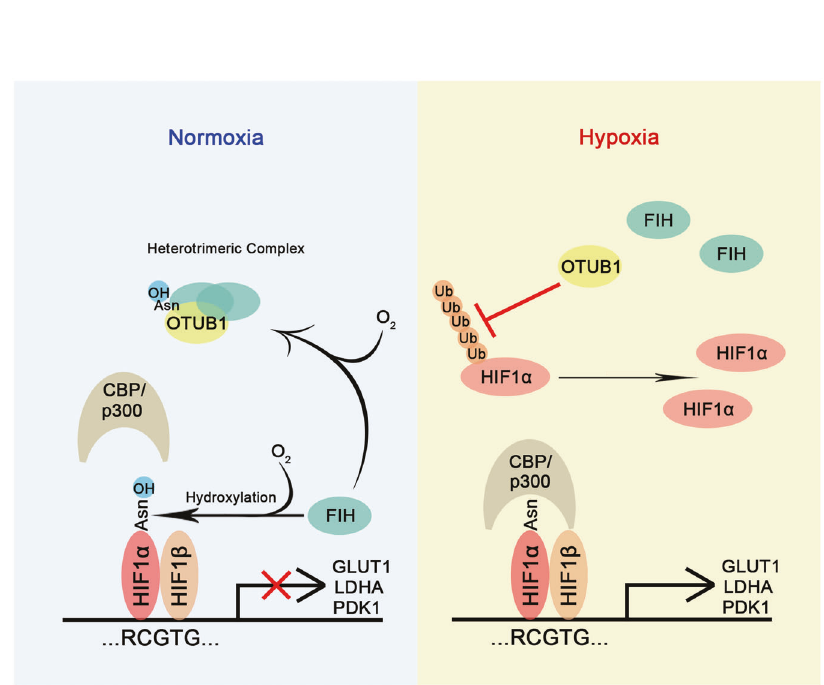
Fig. 7 OTUB1 facilitates hypoxia adaptation. A – D Comparison of GLUT1 ( A ), PDK1 ( B ), LDHA ( C ) and OTUB1 ( D ) expressions in lung cancer tissues ( n = 515) and in the adjacent normal tissues ( n = 59). GLUT1 ( A ), PDK1 ( B ) , LDHA ( C ) and OTUB1 ( D ) mRNA levels in tumors were higher than in normal tissues, as determined by the student ’ s t test. The data were obtained from the Cancer Genome Atlas (TCGA) data (https:// cancergenome.nih.gov/) and analyzed by the online tool UALCAN (http://ualcan.path.uab.edu/). E Linear regression of OTUB1 and GLUT1 across the panels of normal and lung cancer samples described in A , D , was generated by the online analysis tool GEPIA (http://gepia.cancer- pku.cn/) based on TCGA data (https://cancergenome.nih.gov/). F Growth curves of WT or OTUB1 -de fi cient H1299 ( OTUB1 + / + or OTUB1 − / − ) cells ( n = 5) cultured for the indicated days by CCK-8 assay. G , H Colony formation of WT or OTUB1 -de fi cient H1299 ( OTUB1 + / + or OTUB1 − / − ) cells ( n = 3) cultured under hypoxia for the indicated days. I , J Oxygen consumption rate (OCR) changes in wildtype (WT) or OTUB1 -de fi cient H1299 ( OTUB1 + / + or OTUB1 − / − ) cells ( n = 5) under normoxia (Nor) or hypoxia (Hyp) measured by Seahorse XFe24 Extracellular Flux Analyzer ( I ). Statistics of basal respiration, maximal respiration, and spare respiratory capacity were presented in J . K , L Proton ef fl ux rate (PER) changes in WT or OTUB1 -de fi cient H1299 ( OTUB1 + / + or OTUB1 − / − ) cells ( n = 5) under normoxia (Nor) or hypoxia (Hyp) measured by Seahorse XFe24 Extracellular Flux Analyzer. Statistics of basal glycolysis and compensatory glycolysis were presented in L . M – O Glucose uptake in WT or OTUB1 -de fi cient H1299 ( OTUB1 + / + or OTUB1 − / − ) cells ( n = 3) under normoxia or hypoxia analyzed using fl uorescent glucose analog 2-NBDG and detected by fl uorescence microscopy (M), and fl ow cytometry analysis ( N , O ).